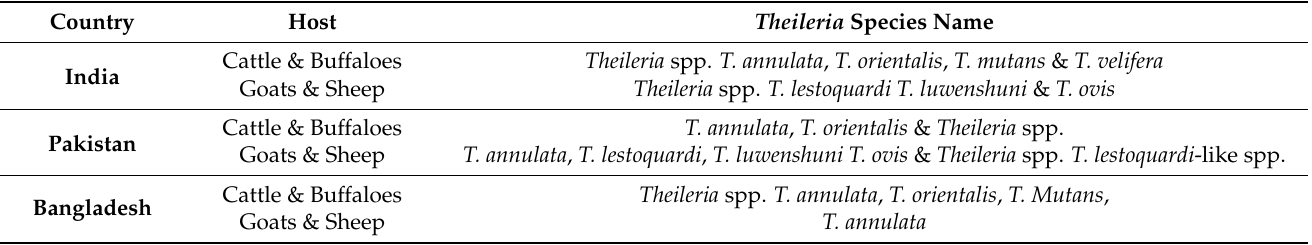
Table 1. Common Theileria species found in India, Pakistan and Bangladesh.